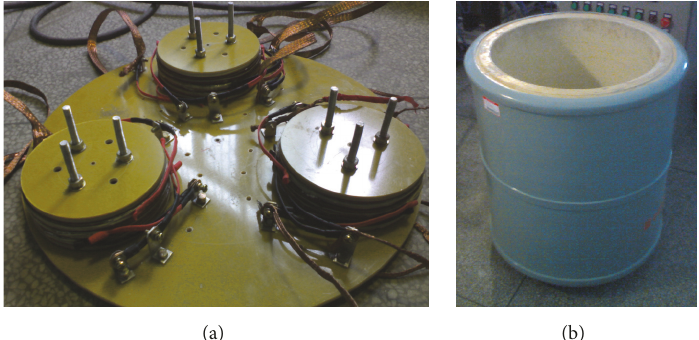
Figure 3: (a) Physical diagram of the three-phase air-core superconducting transformer. (b) Physical diagram of the